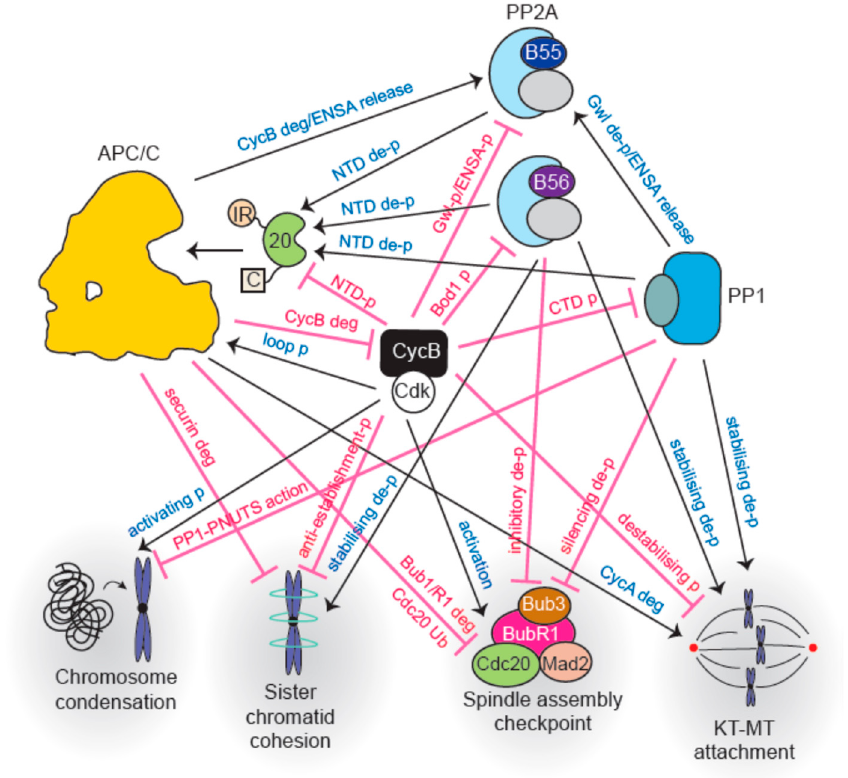
Figure 4. The APC / C and cell cycle phosphatases display complex interactions, influencing not only each other but also numerous events in mitosis and transition into anaphase. Black arrows indicate stimulation; red T-bars indicate inhibition. See text for details. Abbreviations: CycB, Cyclin B; de-p, dephosphorylation; deg, degradation; KT-MT, kinetochore-microtubule; p, phosphorylation; Ub, ubiquitylation.